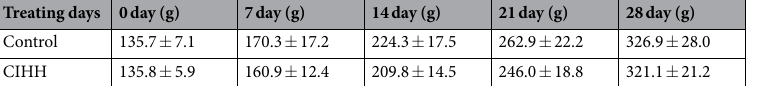
Table 1. Effect of CIHH on body weight in rats. All data expressed as mean ± SD, n = 6 for each group.